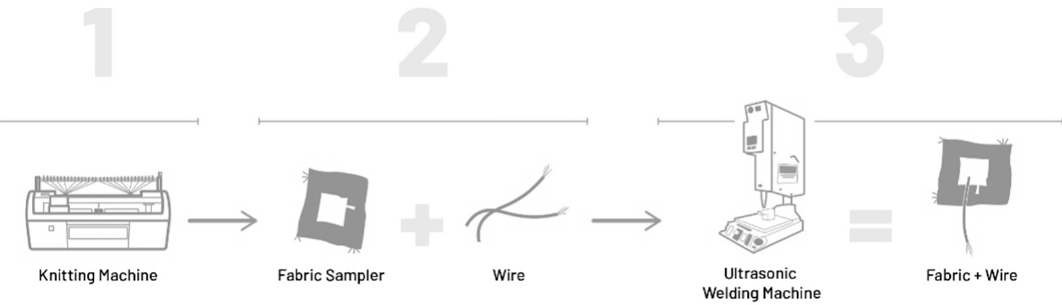
Figure 1. Schemes follow the same formatting.